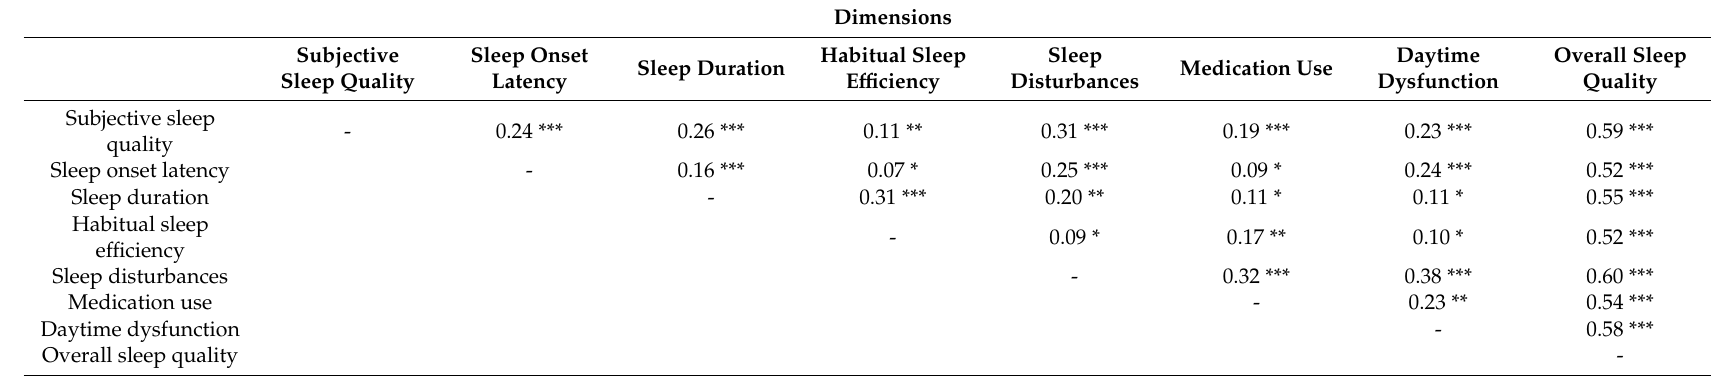
Table 1. Overview of the intercorrelations between the seven dimensions of the Pittsburgh Sleep Quality Index